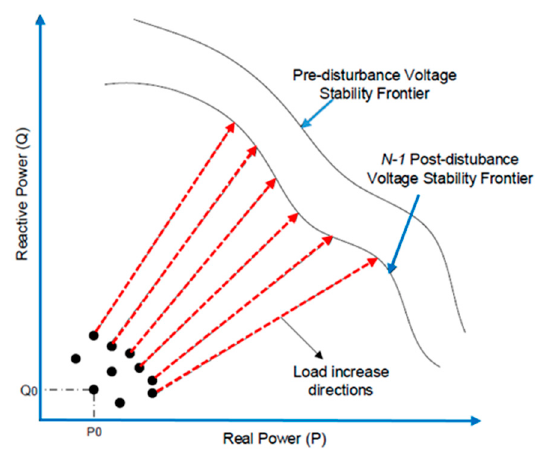
Figure 9. Voltage stability margin (VSM) variation [108].